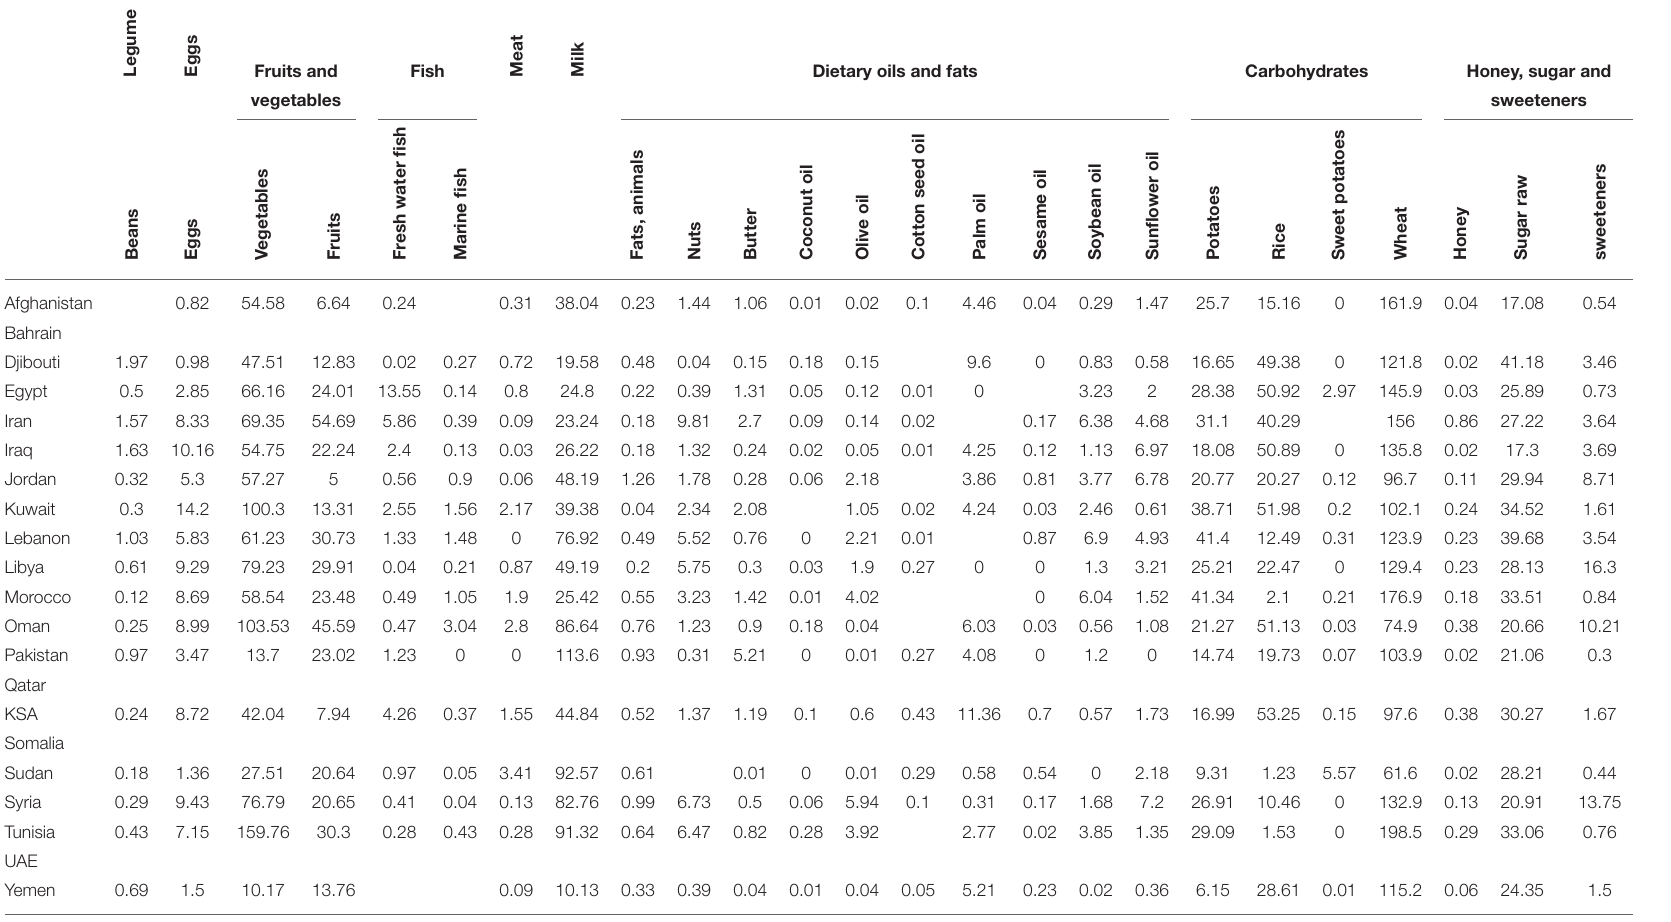
TABLE 3 | Food consumption in EMR (2019)